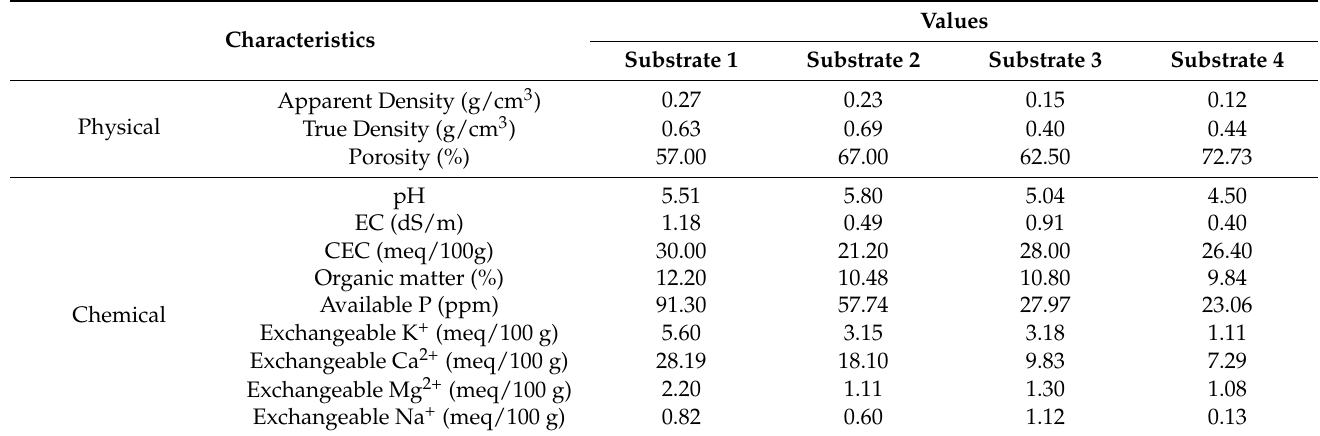
Table 1. Physical and chemical characteristics of the substrates used for acclimatization of strawberry variety